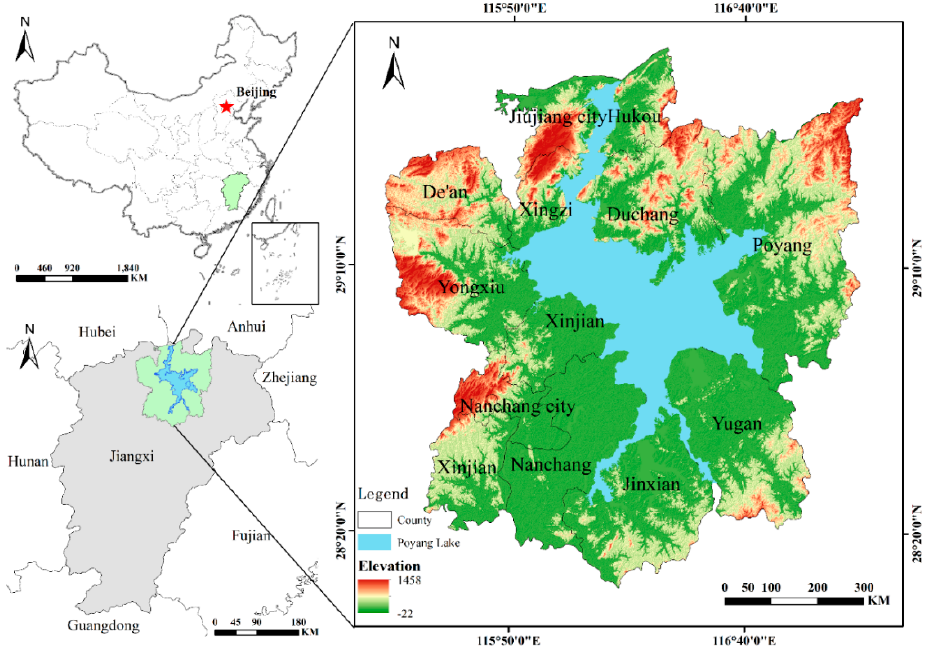
Figure 2. Location and range of the PYL area, China.